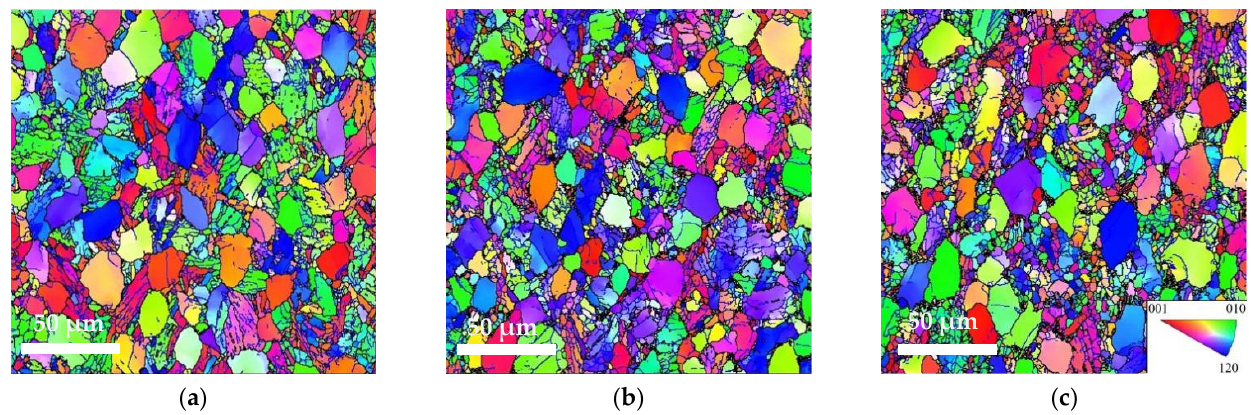
Figure 7. IPFs of specimens with pre ‐ deformation strain of 0.05 at different true strains: ( a ) 0.3; ( b ) 0.5; and ( c ) 0.7.